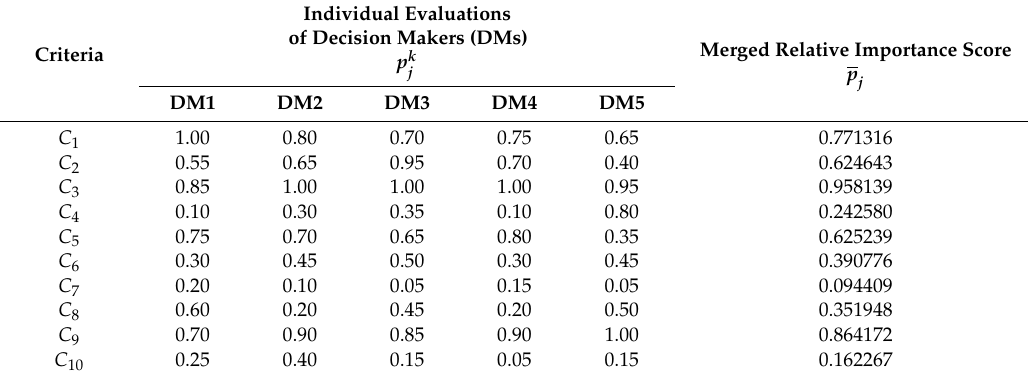
Table 2. Evaluations of decision makers for criteria and merged relative importance scores.